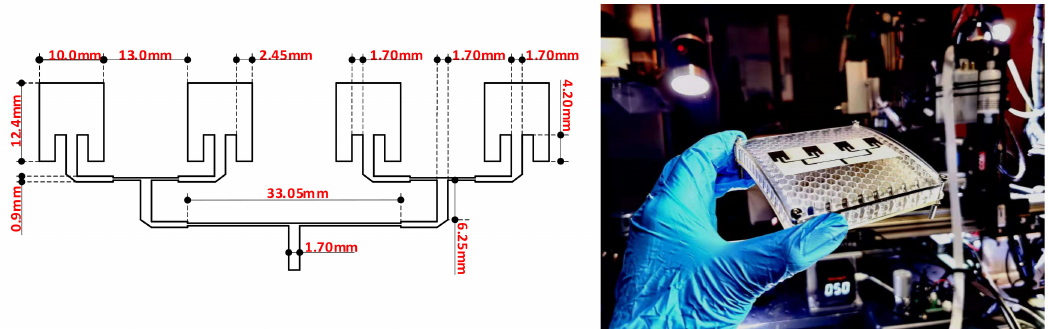
Figure 14. Design and manufactured product of the antenna.